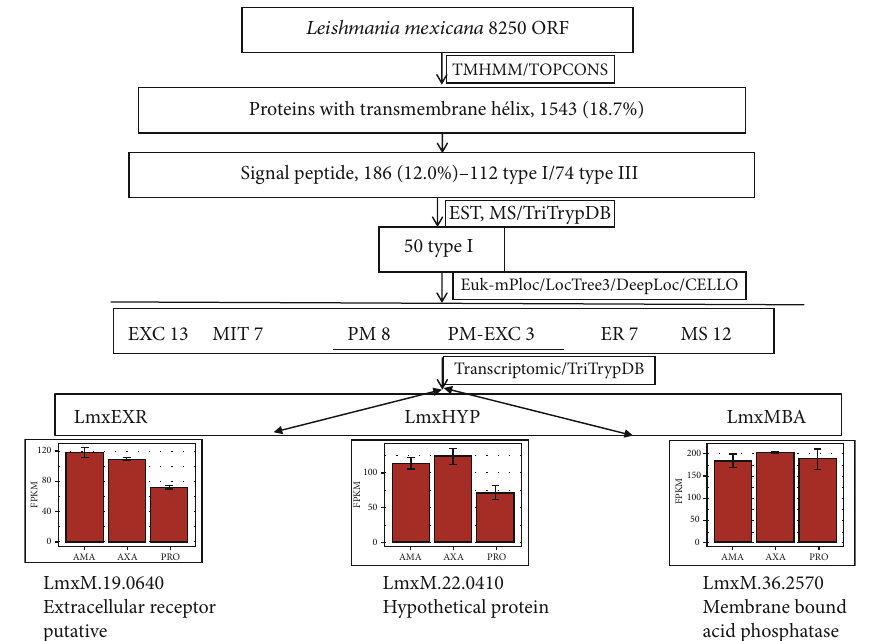
Figure 1: Strategy to identify putative vaccine candidates in L. mexicana . Abbreviations: EXC: excreted; MIT: mitochondria; PM: plasma membrane; ER: endoplasmic reticulum; MS: multiple